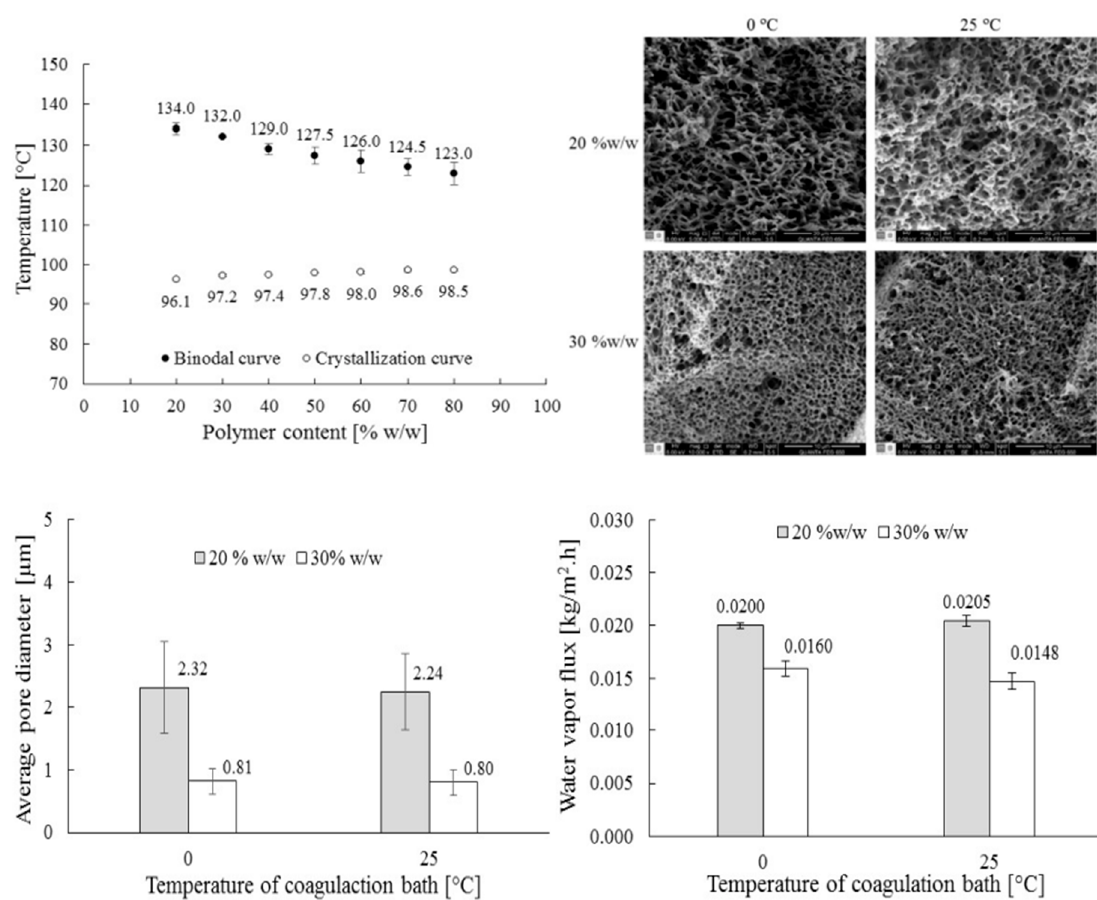
Figure 10. The effect of L–L phase separation kinetics on the LDPE-palm oil membrane morphology. ( Top left ) phase diagram, ( top right ) SEM images of the LDPE membrane cross-section, ( bottom left ) average pore diameter of the membrane as a function of the coagulation bath temperature, and ( bottom right ) water vapor flux through the membrane as a function of the coagulation bath temperature, adapted from [7].